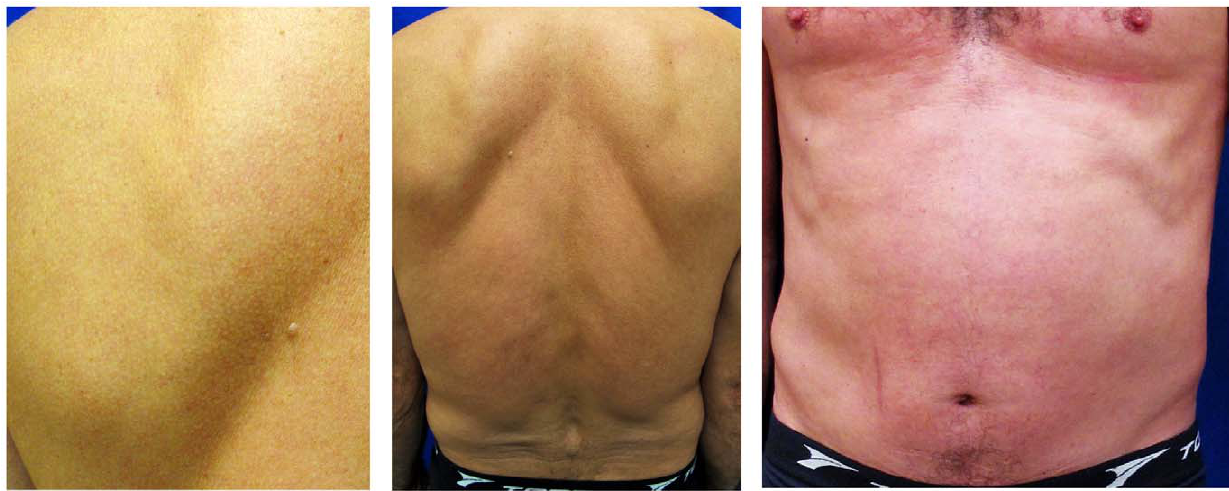
Figure 2. Complete remission after 1 week of treatment. No lesions on the back and abdomen.